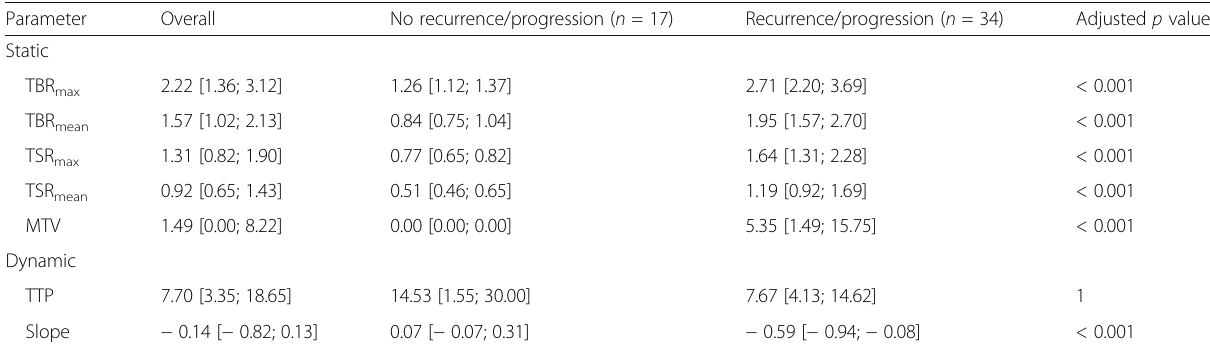
Table 2 Median [interquartile range] of PET parameters in the overall population as well as comparatively between the 2 groups of patients with or without glioma recurrence or progression